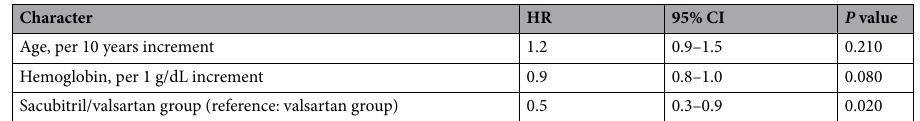
Table 4. Risk for function decline by multivariate Cox proportional regression. HR hazard ratio, CI confidence interval.